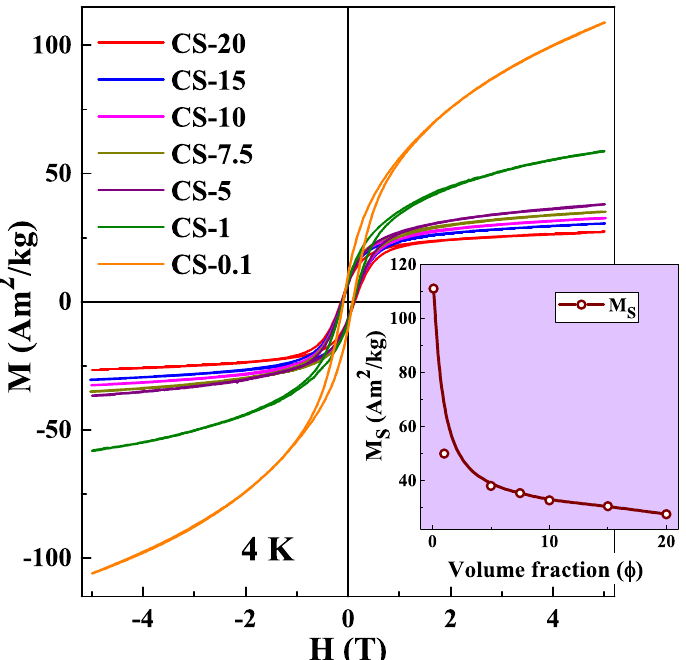
Figure 5. M − H loops of samples CS-20, CS-15, CS-10, CS-7.5 CS-5, CS-1, CS-0.1 measured in ZFC mode. Inset shows the variation of M S with volume fraction ( ϕ